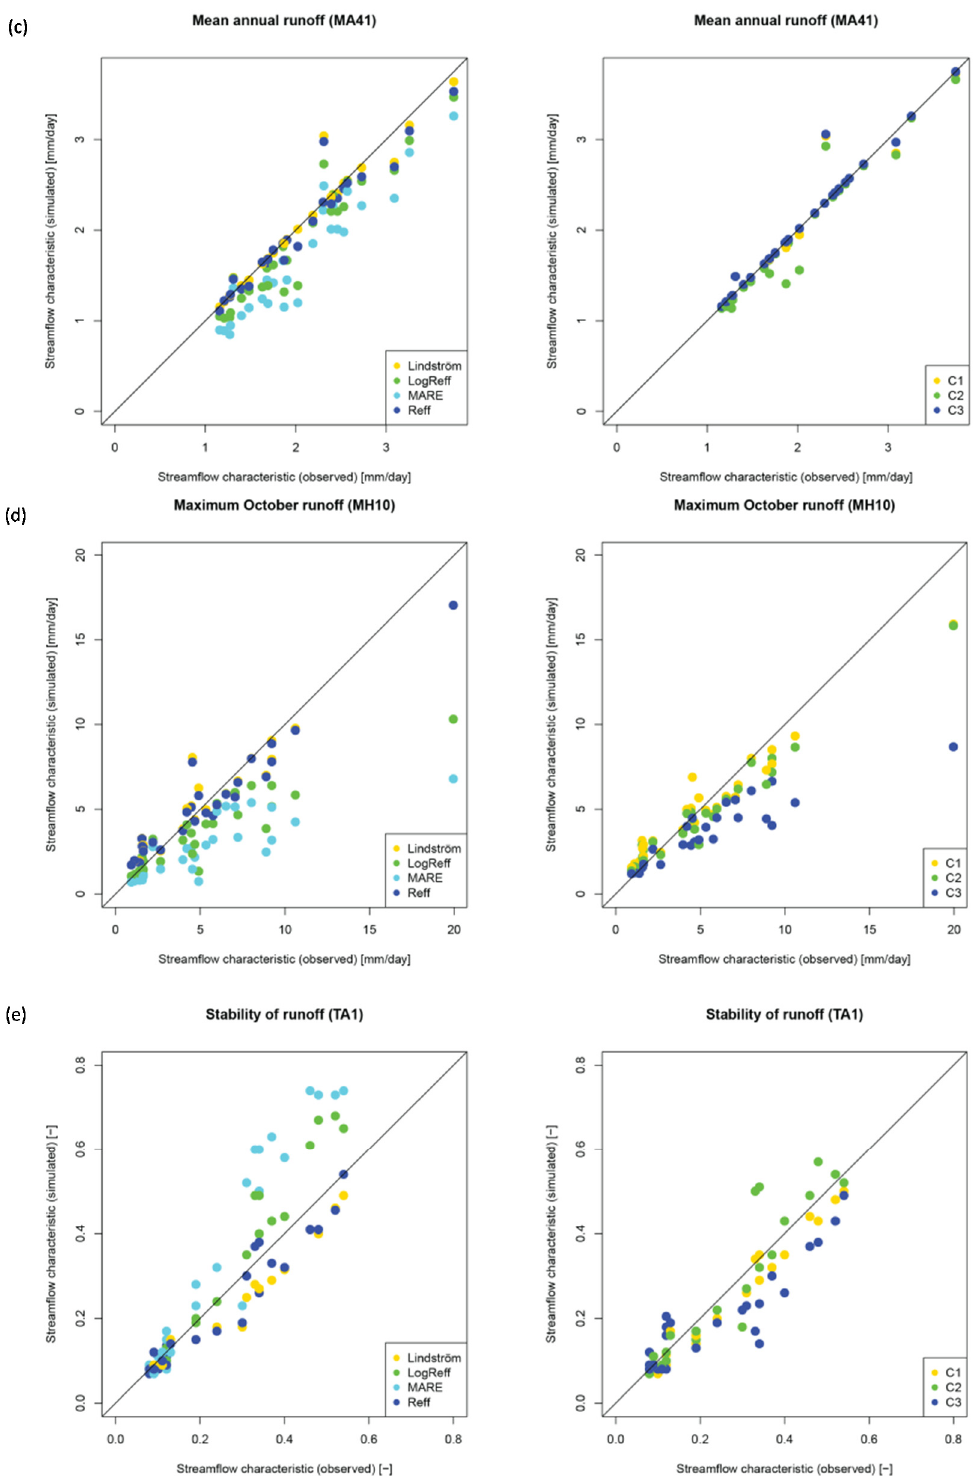
Figure 5. Scatterplots for the streamflow characteristics ( a ) DH16 (Variability in high-flow pulse duration); ( b ) FL2 (Variability of low-flow pulse count); ( c ) MA41 (Mean annual runoff); ( d ) MH10 (Maximum October runoff) and ( e ) TA1 (Stability of runoff) for calibration period 1. The points represent the median value of all 100 calibration trials in each catchment based on single criteria objective functions ( left column ) and multi-criteria objective functions ( right column